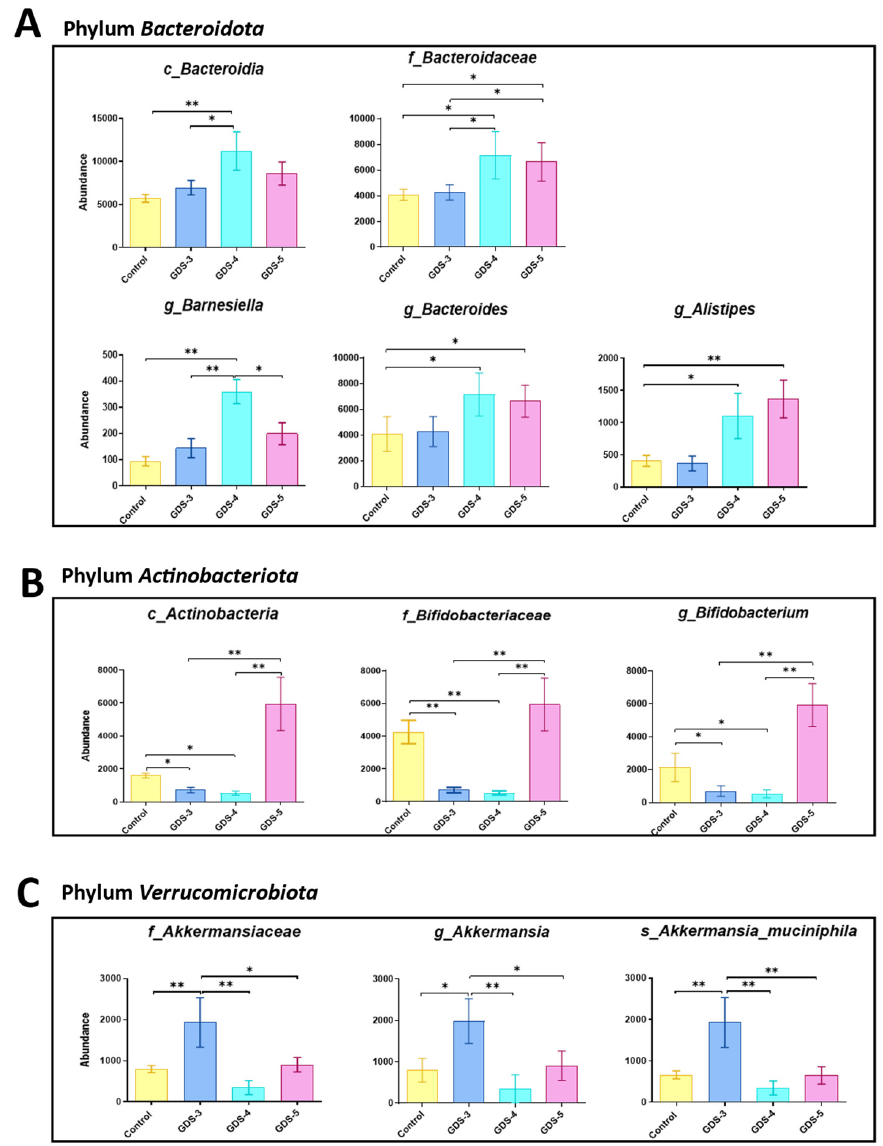
Figure 9. Gut microbiota in the Alzheimer’s disease (AD) patients and the control subjects. The relative abundance of the bacterial taxa in the feces from the control subjects and the AD patients classified in the stages GDS-3, GDS-4 and GDS-5. The data are the means ± the SEM; (n = 10, control subjects; n = 12, AD patients; 4 per stage). ( A ) The bacterial class, family and genera belonging to the phylum Bacteroidota . ( B ) The bacterial class, family and genera belonging to the phylum Actinobacteria . ( C ) The family Akkermansiaceae , genus Akkermansia and species Akkermansia muciniphila . The ANOVA shows an effect ( p < 0.05) between the bacterial taxa and the AD patients classified in the stages. Tukey’s test: * p < 0.05and ** p < 0.01. c, class; f, family; g, genus, s, species.